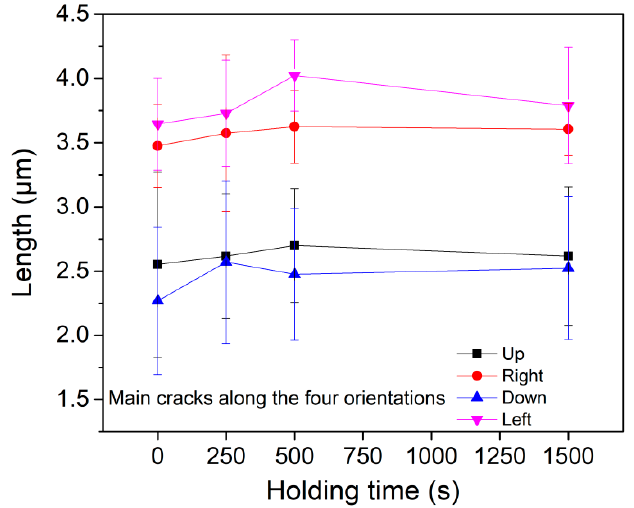
Figure 7. The correlation between main crack length and holding time along the four directions.